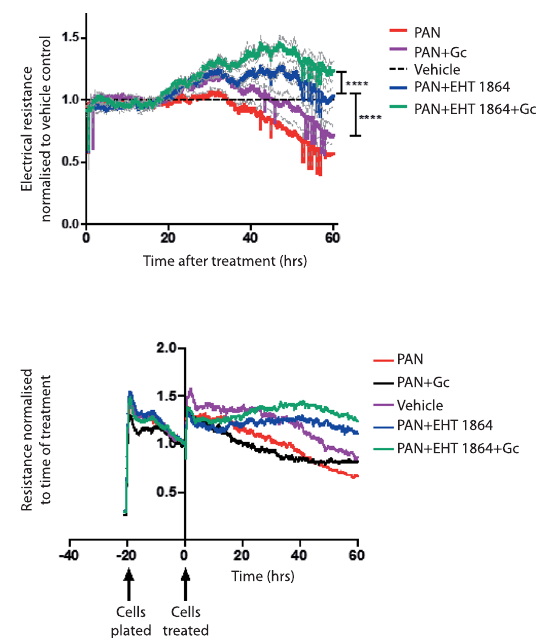
Figure 7. Effect of Rac1 inhibition on podocyte barrier function. The effects of Rac1 inhibition with the small molecule EHT 1864 on electrical resistance across a monolayer of podocytes was examined using electrical cell-substrate impedance sensing (ECIS). Here, electrical resistance is used as a surrogate marker for cell barrier integrity, with higher electrical resistance implying higher barrier integrity. ( a ) Shows the combined results of three experiments normalised to the vehicle control. Each experiment consisted of 3 plated wells of cells per condition, with each experiments lasting for 60 hours following treatment. The experiment was performed three times. Measured electrical resistances during the final 30 minutes of the experiment for each condition were used for final statistical analysis. Statistical analysis was performed using one-way ANOVA followed by Tukey’s multiple comparisons test. **** = p value < 0.0001. The thin grey lines represent standard error of the mean. ( b ) shows an example of a single experiment, with the resistance on the y-axis normalised to measured resistance at the time of treatment for each